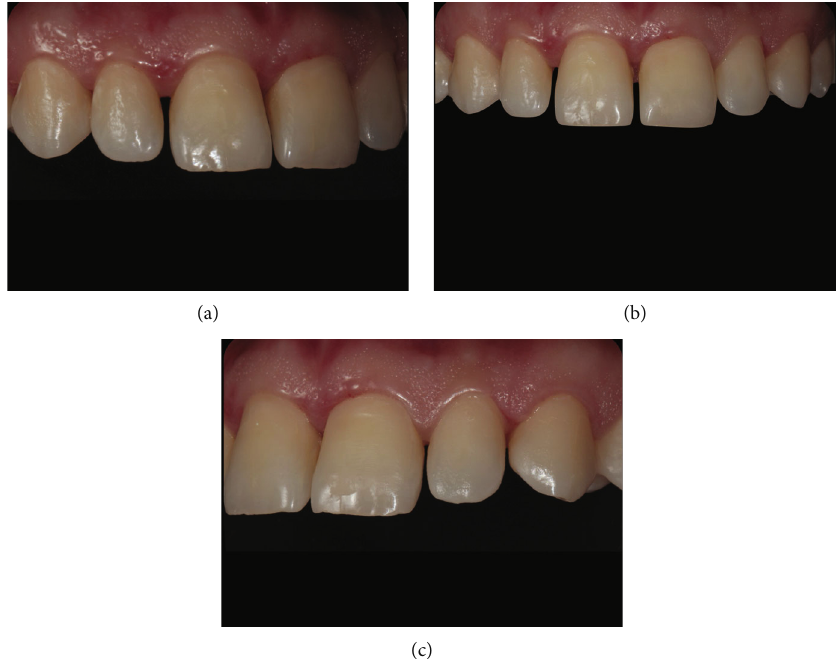
Figure 6: One year recall photographs with di ff erent angles. (a) Right angle, (b) Front angle, (c) Left